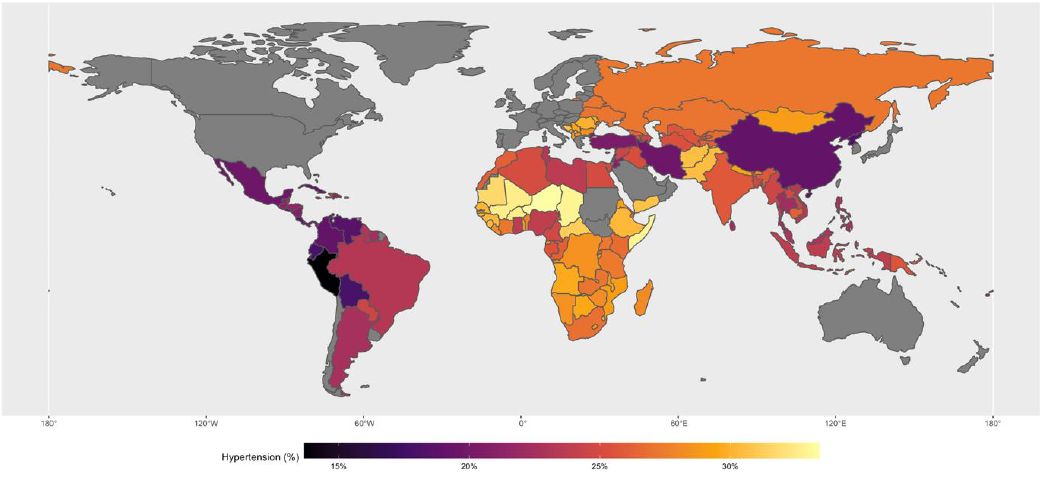
Figure 1. The median prevalence of age-standardised hypertension in studied countries. The pair-wise correlation between hypertension and the eight factors is summarised in Table 2. There was a negative statistically significant weak correlation between hypertension prevalence and domestic healthcare expenditure (r = − 0.36; 95%CI = − 0.50 to − 0.20), and negative statistically significant moderate correlation between hypertension, gross domestic product per capita (PPP) (r = − 0.46; 95%CI = − 0.59 to − 0.31), adult literacy rate (r = − 0.56; 95%CI = − 0.67 to − 0.42), and percentage living in urban areas (r = − 0.46; 95%CI = − 0.59 to − 0.32). In addition, there was a positive statistically significant moderate correlation between hypertension prevalence and the multidimensional poverty index (r = 0.59; 95%CI = 0.45 to 0.71), indicating that the multidimensional poverty index increases with the prevalence of